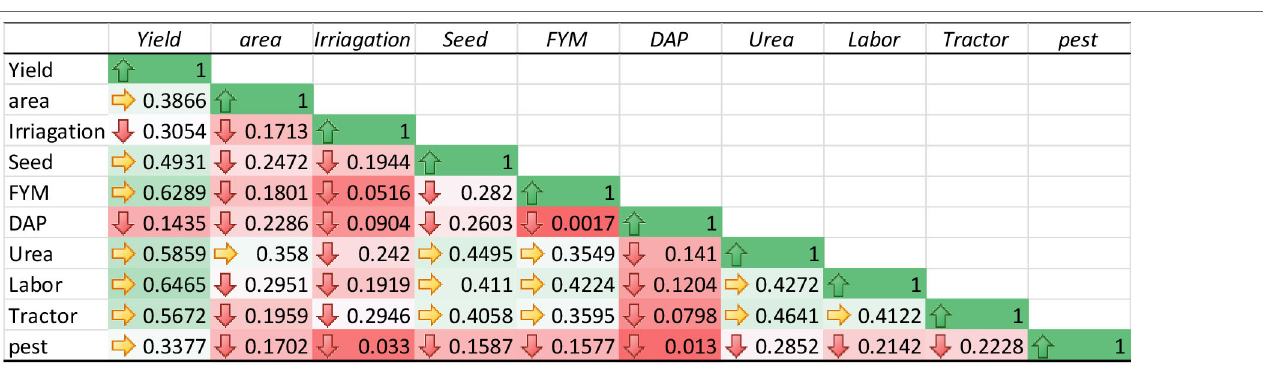
TABLE 5 | Pearson’s correlation analysis of deep placement fertilization.